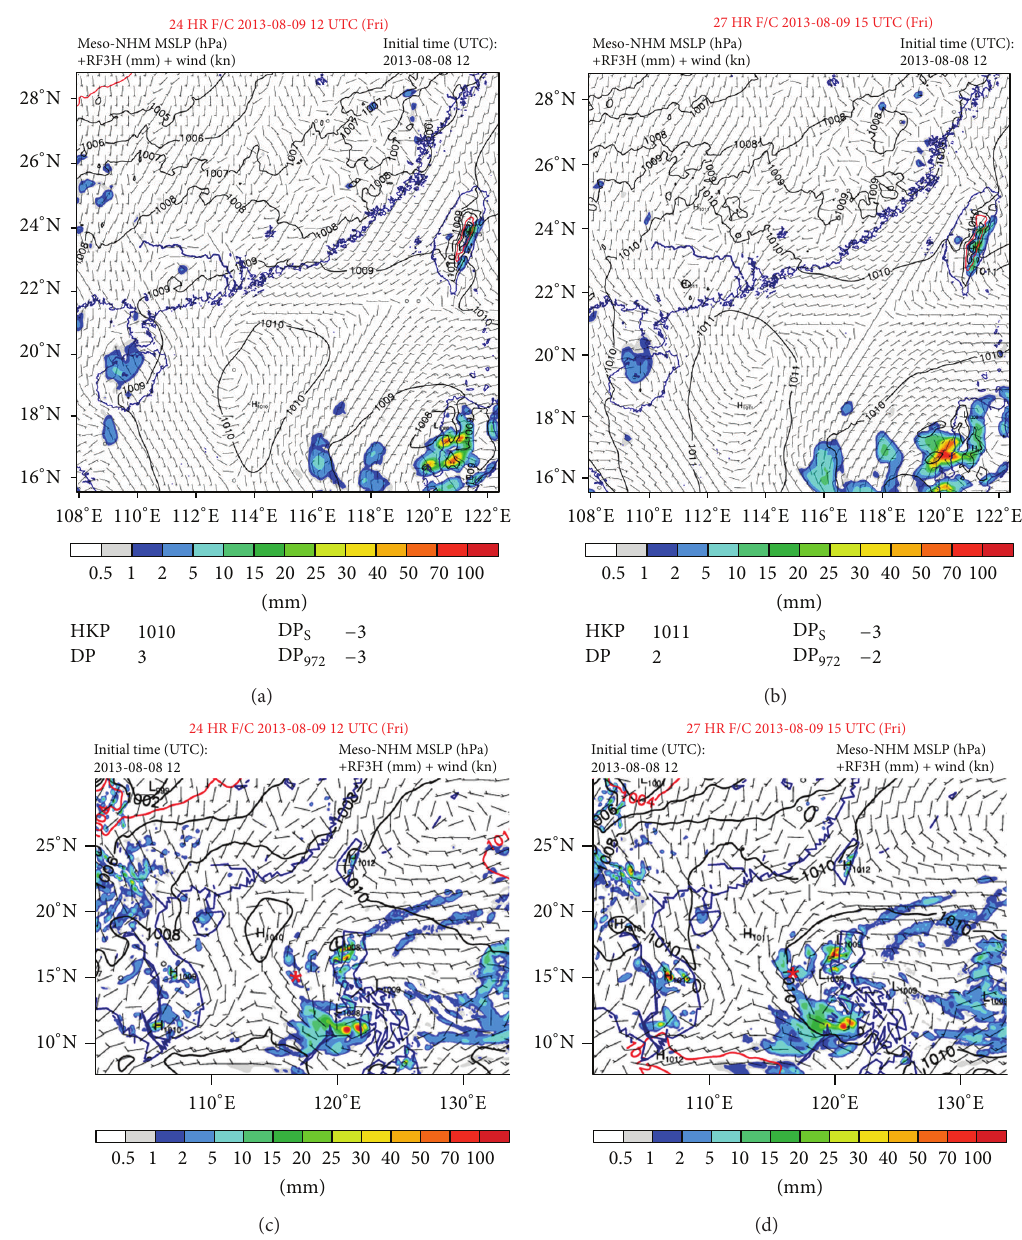
Figure 10: T+24-hour and T+27-hour forecast of surface wind, mean sea level pressure (contour), and 3-hour accumulated rainfall (shaded) from NHM run at 1200 UTC, 8 August 2013. The asterisk shows the location of the turbulence event.